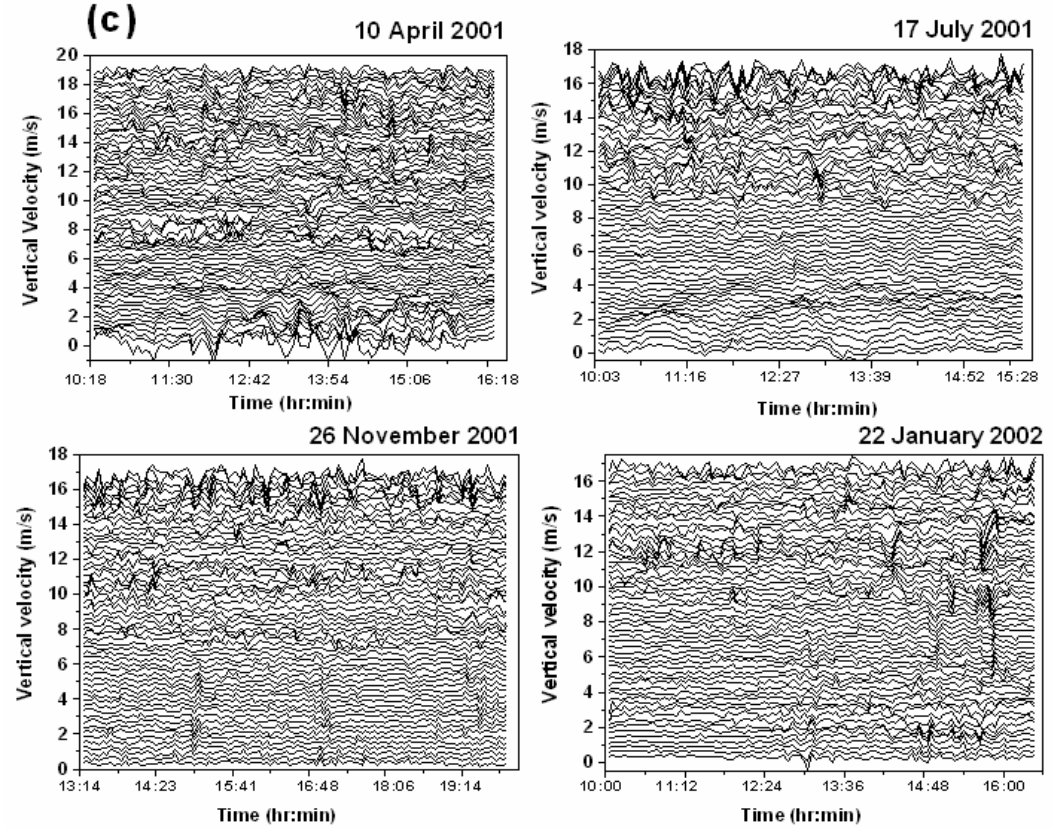
Fig. 2. Continued. Same as Fig. 2a, but for the vertical velocities during the same days. For clarity each profile has been shifted by